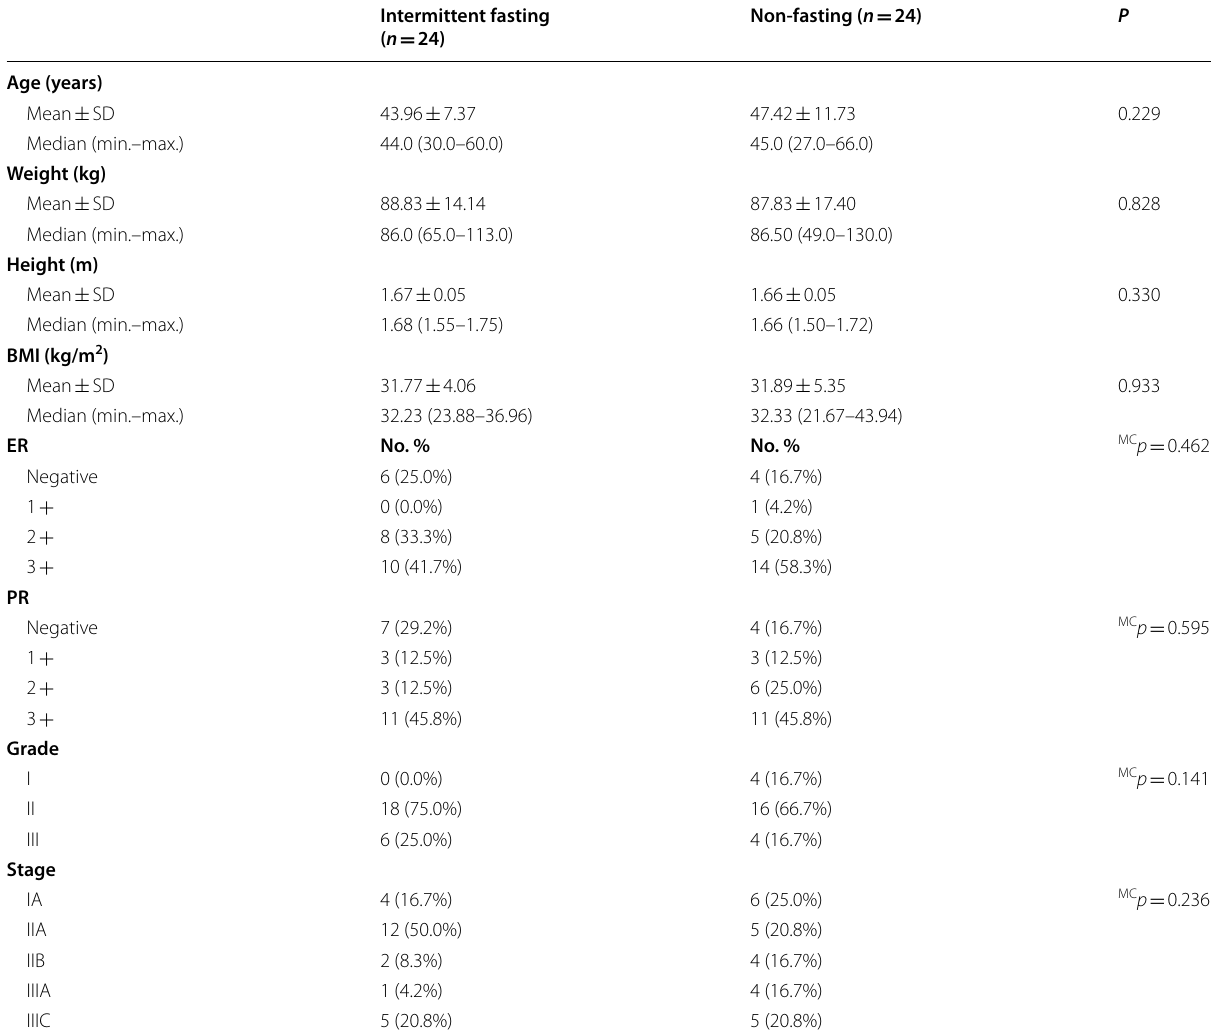
Table 1 Comparison between the two studied groups according to baseline patient characteristics